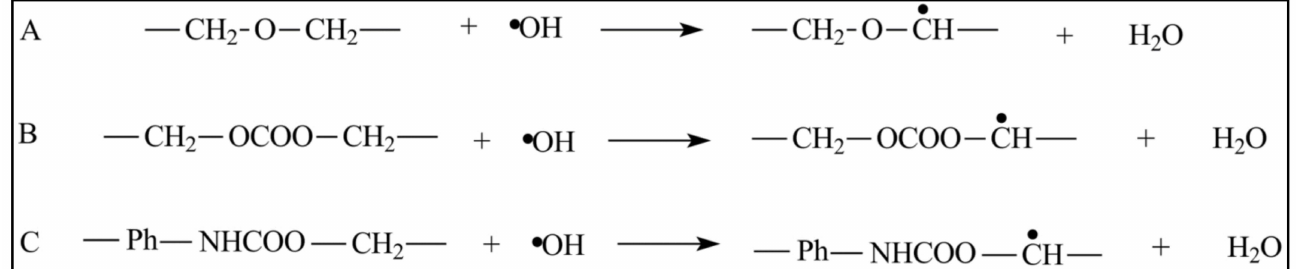
Figure 9. A mechanism of oxidative degradation by H 2 O 2 in poly(ether urethanes) ( A ), poly(carbonate urethanes) ( B ), and aromatic polyurethanes ( C )